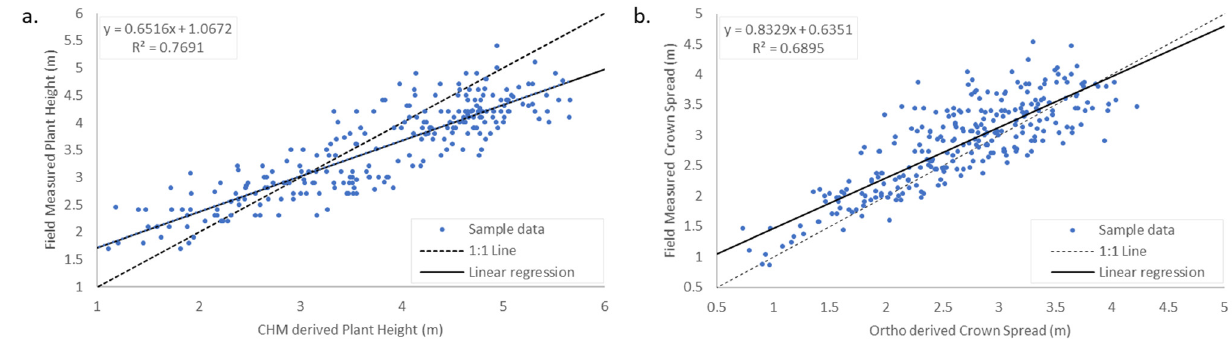
Figure 6. Scatterplot and linear regression of ( a ) banana plant height derived from the CHM created from UAV data and field-measured height and ( b ) banana plant crown spread based on the orthomosaic created from UAV data and field-measured crown spread.